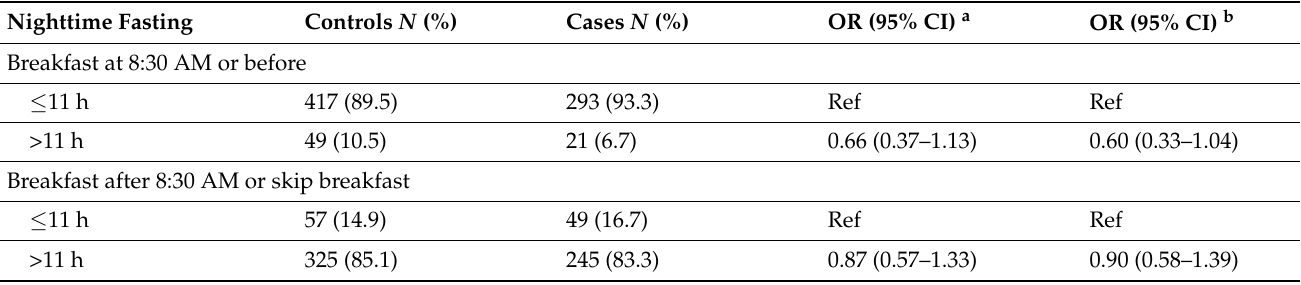
Table 4. Association of nighttime fasting and prostate cancer risk stratified by time of breakfast.